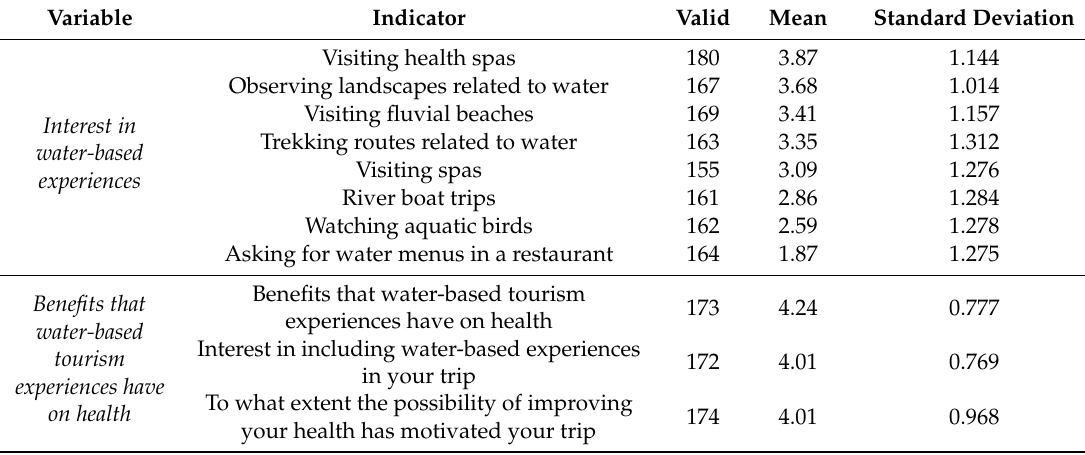
Table 3. Opinion about water-based